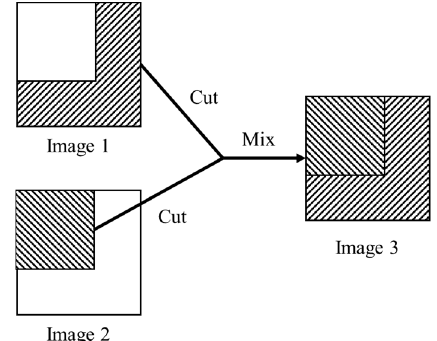
Figure 5. Schematic of CutMix.